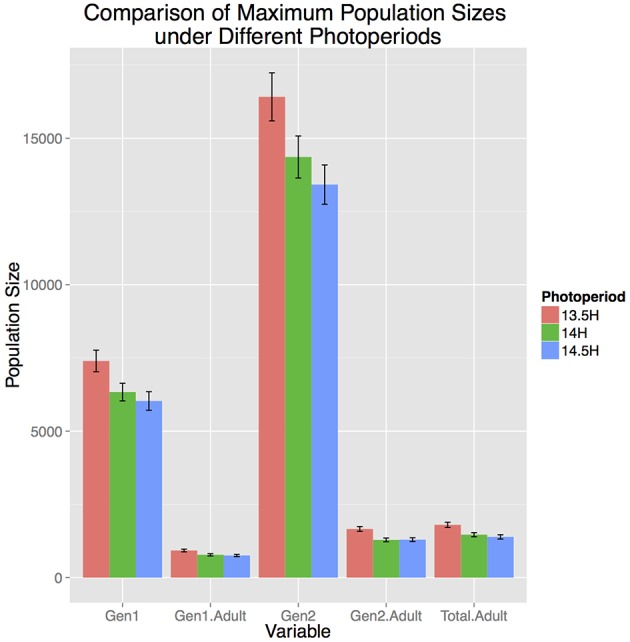
Influence of three photoperiod cues on total population size in Allentown, PA, 2007. Photoperiod units are hours of daylight, and are assumed to influence both diapause termination in the Spring, and diapause initiation after the summer solstice.